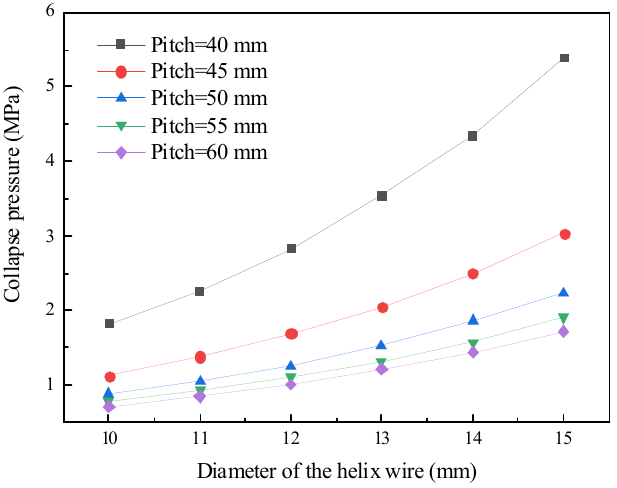
Figure 18. Collapse pressure vs. helix wire diameters in different pitch of the helix wire.